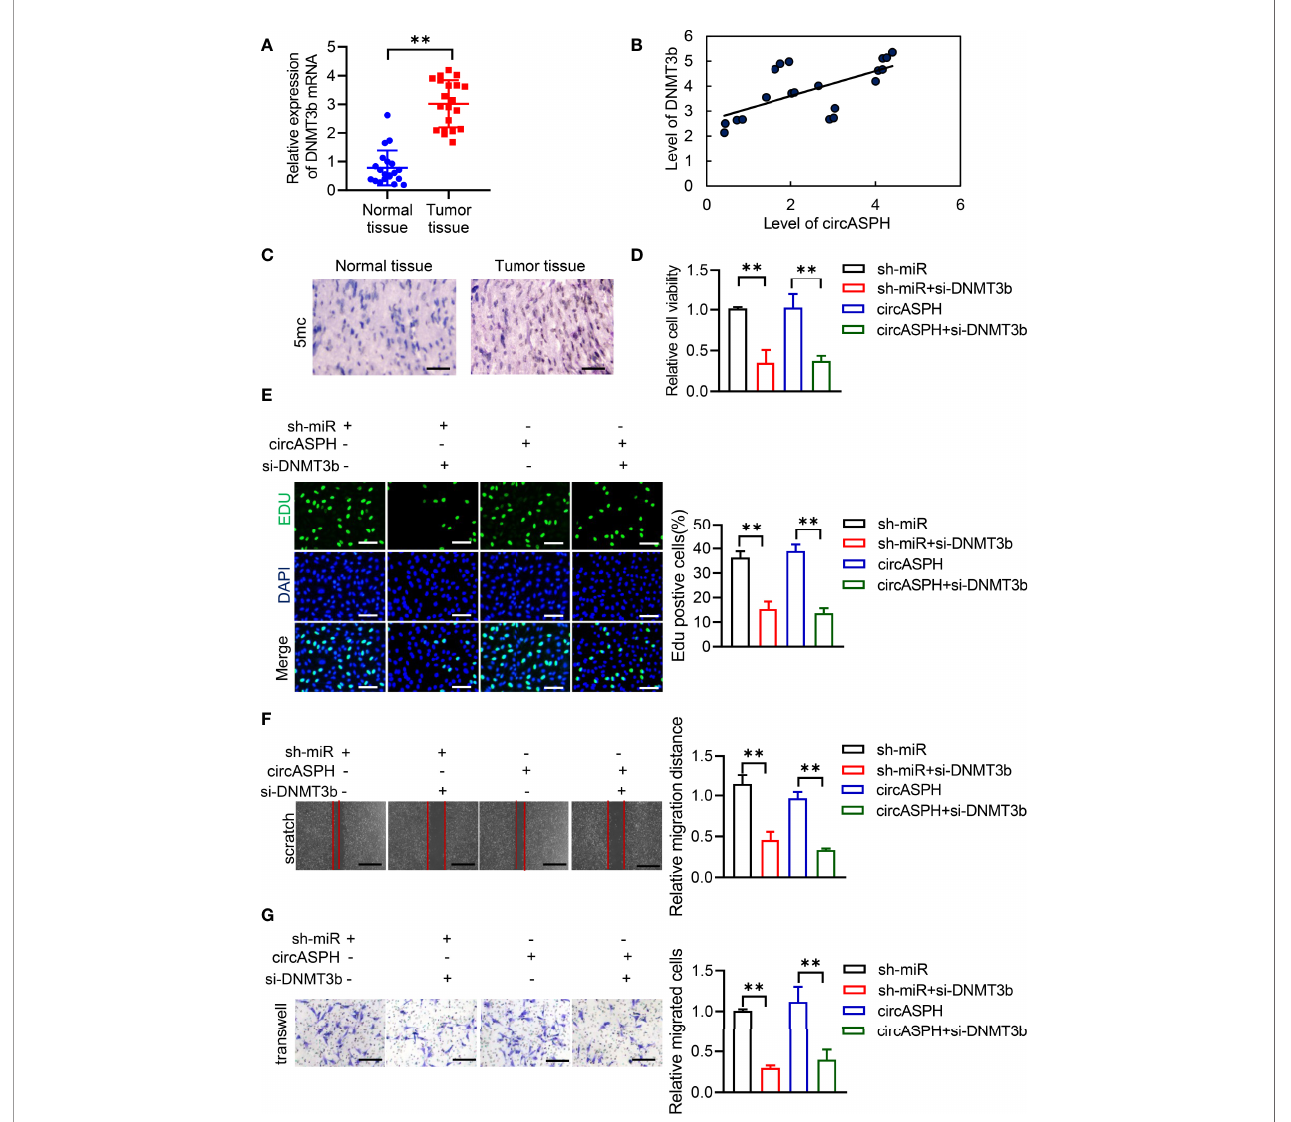
FIGURE 5 | CircASPH promoted the HCC process via miR-370-3p/DNMT3b/5mC. (A) The level of DNMT3b expression was evaluated by RT-qPCR in 20 paired HCC tumor tissues and normal tissues. (B) Pearson analysis indicated the relationship between circASPH and DNMT3b. (C) Immunohistochemical staining for 5mC in HCC tumor tissues; scale bar = 100 m m. (D, E) Cell Counting Kit-8 (CCK-8) assays and EDU staining assays indicated the proliferation of cells expressing a combination of circASPH, sh-miR-370-3p, and si-DNMT3b. (F, G) Wound-healing assays and Transwell assays indicated the ability of migration and invasion of cells expressing a combination of circASPH, sh-miR-370-3p, and si-DNMT3b. **p <